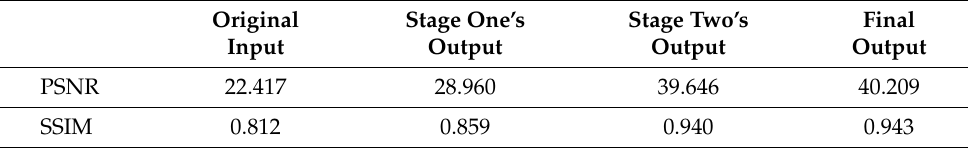
Table 6. Restoration results of different patch interception